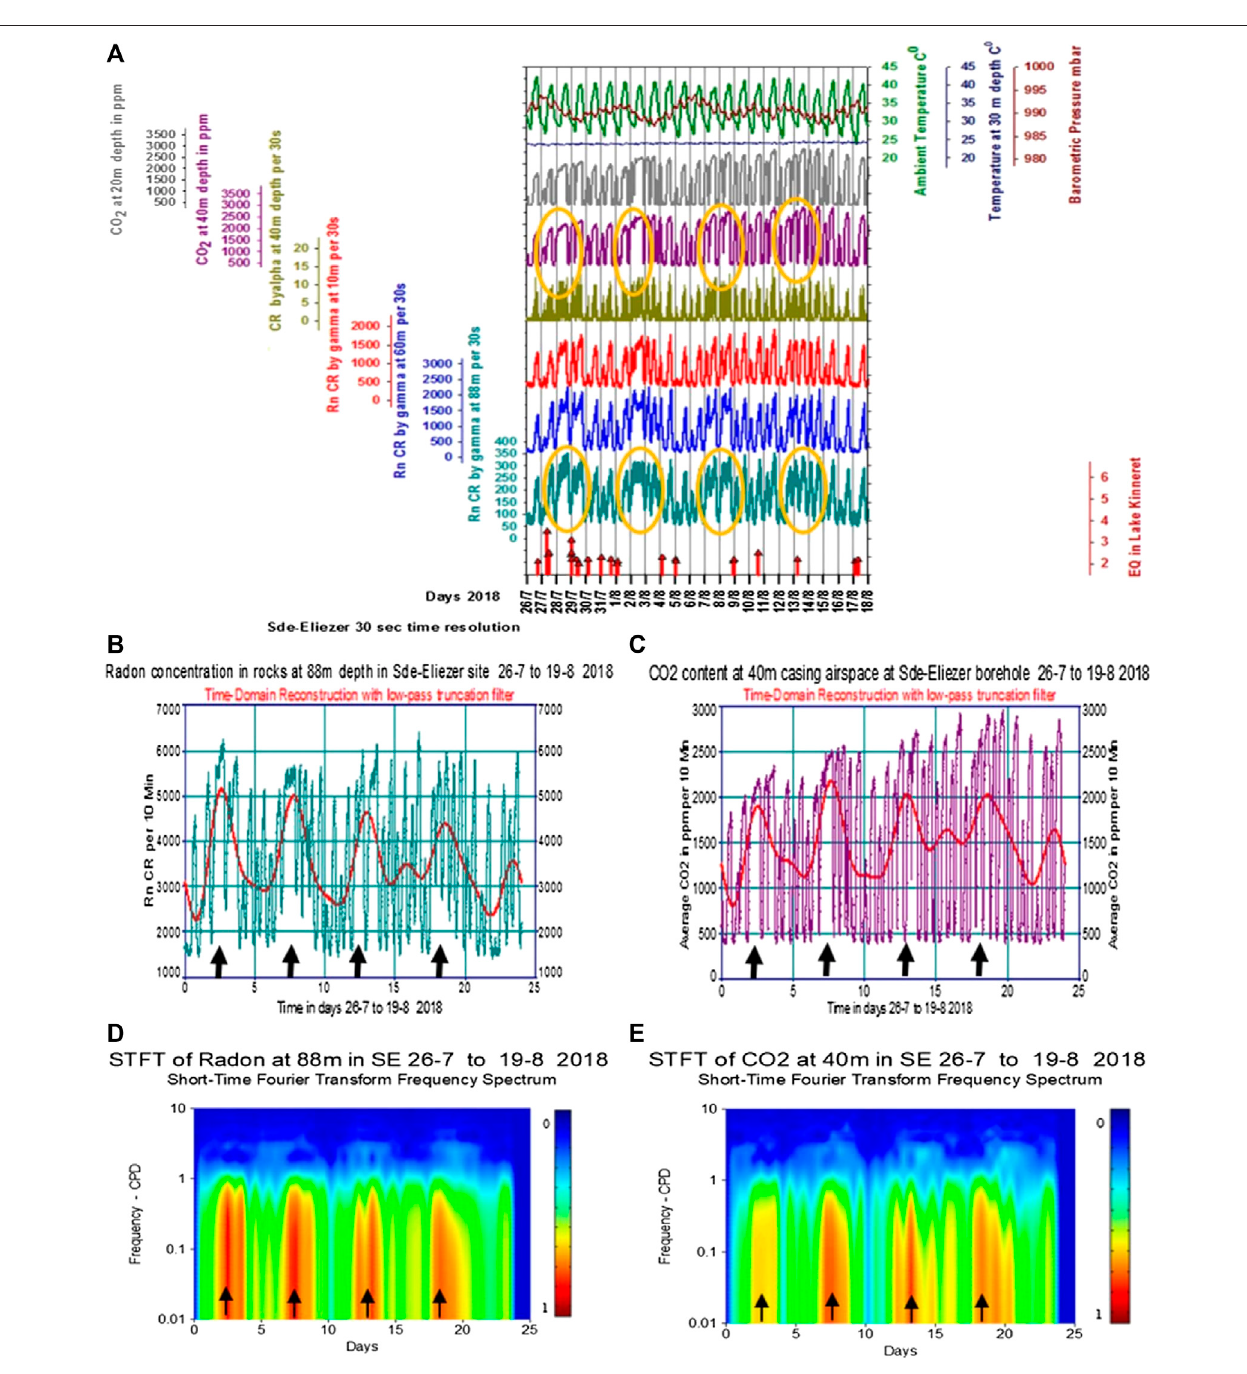
FIGURE 15 | (A) Time series of 24 consecutive days at the Sde-Eliezer site in the time interval of 26 July to August 18, 2018. (B) Time domain reconstruction with low-pass truncation fi lter of the radon ’ s 88 m, and (C) Time domain reconstruction with low-pass truncation fi lter of the CO 2 ’ s 40 m time series . It shows the same discrete radon and CO 2 broadened signals on 28 and 29 July, 2, 7, 8 and August 13, 2018, that are marked with black arrows also in (D) and (E) , that are the radonandtheCO 2 spectrogram.Inthis fi gure,0.1countsper30 softhegammasensorsat10,60and88 m,areequivalenttoconcentrationof1 Bq/m 3 withinthe surrounding country rock, and 0.0015 counts per 30 s of the alpha particle detector is equivalent also to 1 Bq/m 3 .